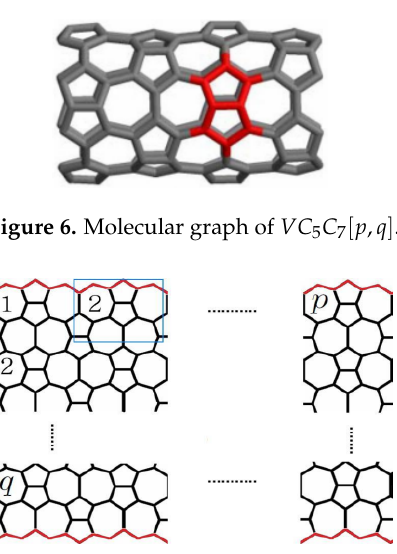
Figure 7. 2 dimensional lattice of VC 5 C 7 [ p , q ] .